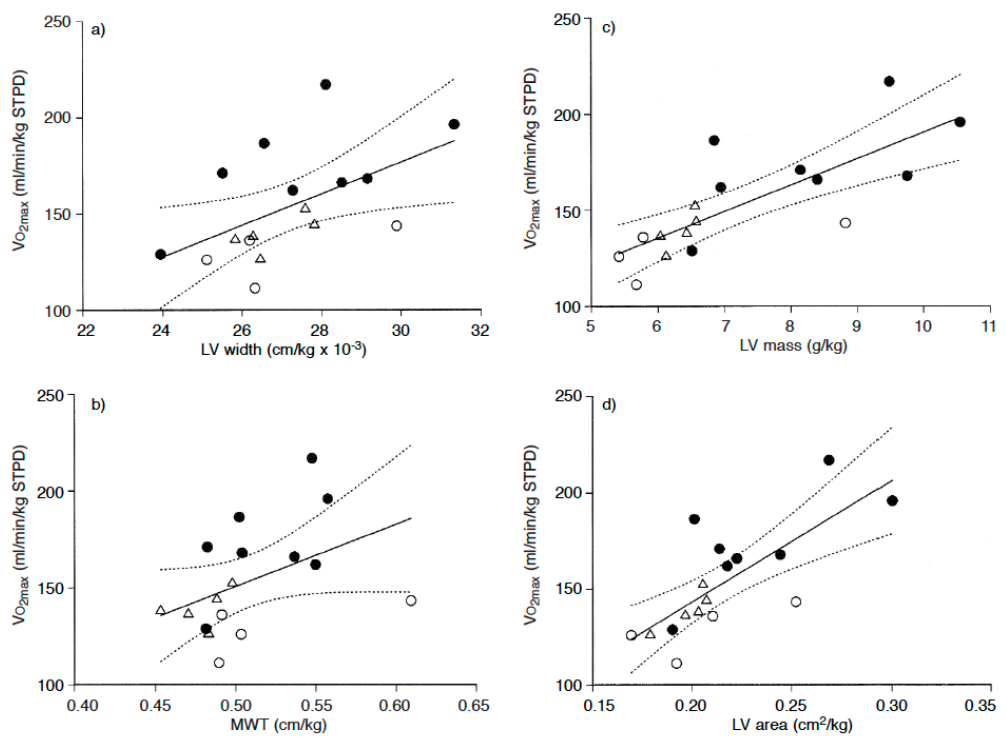
Figure 6. Relationships between various measures of heart size ( LV width ( a ), mean wall thickness ( b ), LV mass ( c ), LV area ( d )) and V O 2max in a range of horses. Taken with permission from Young et al., [38].